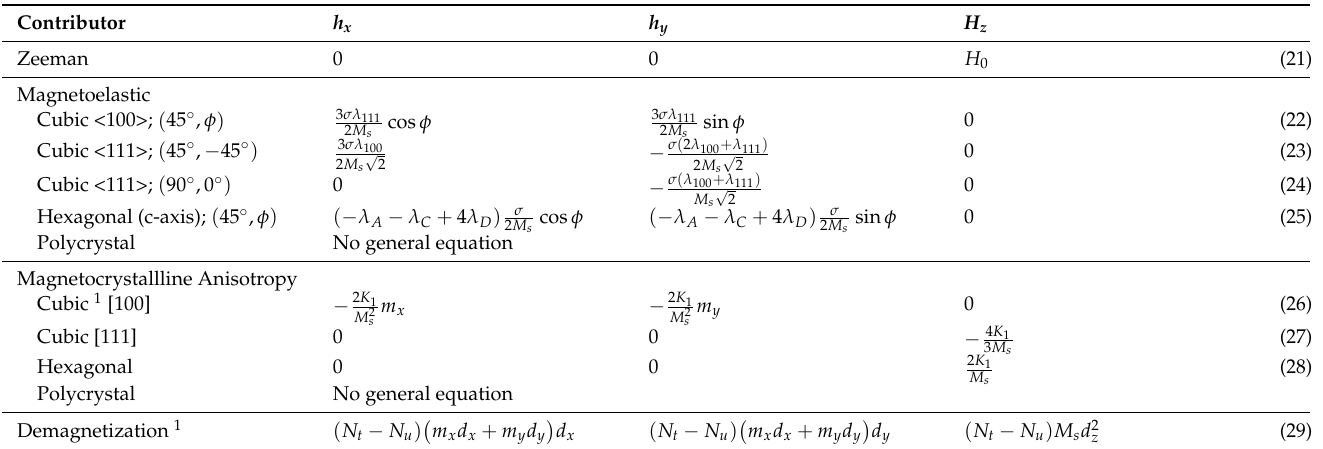
Table 2. Linearized effective magnetic field